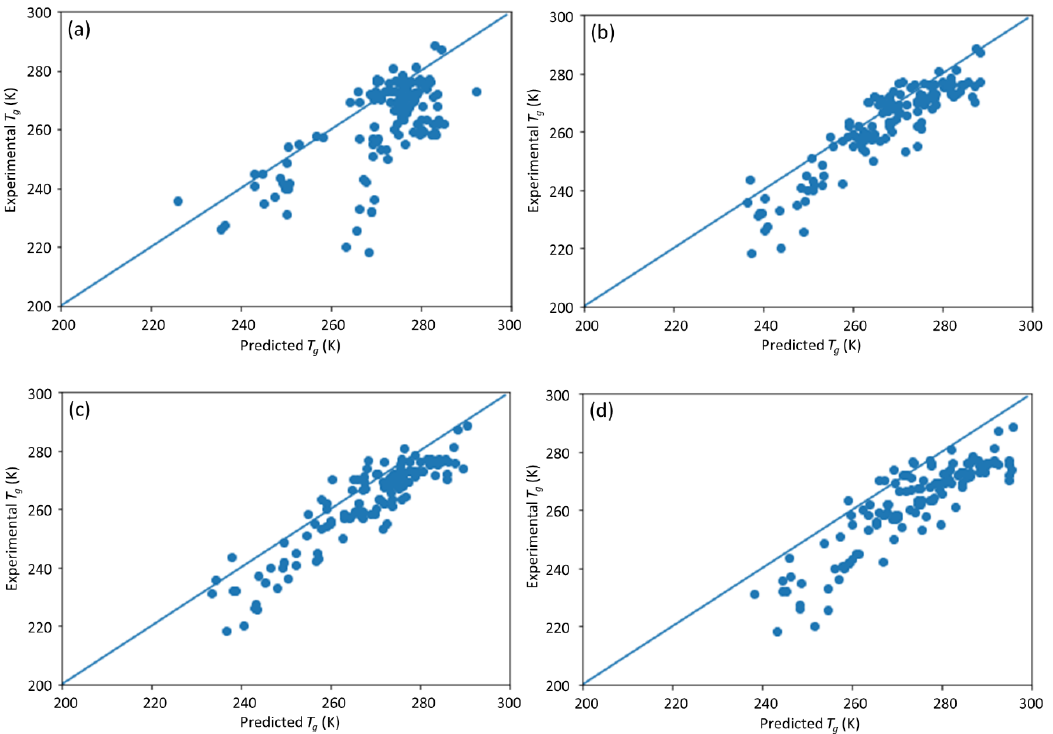
Figure 12 Figure 12. Scatter plots of the predicted vs. experimental T g with di ff erent input factors estimated with their maximum values. ( a ) Fractional composition of A; ( b ) molecular weight; ( c ) PDI; ( d ) molecular weight and